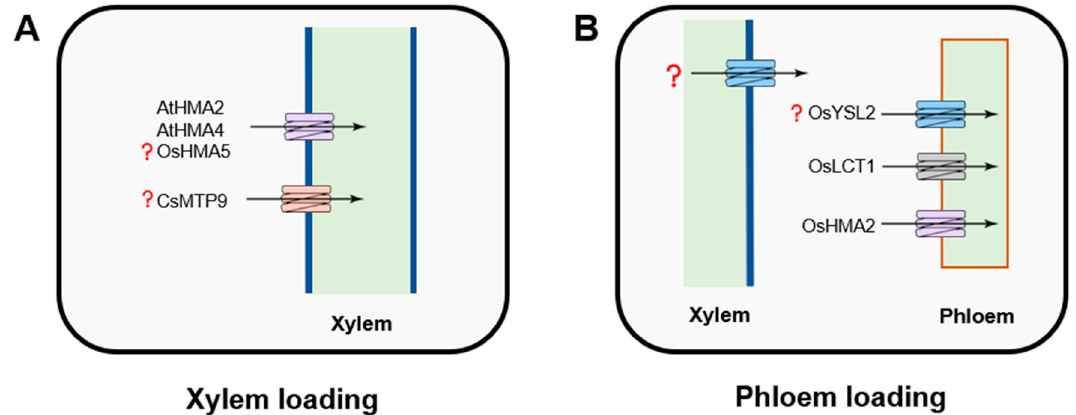
Figure 3. Transporters mediating xylem ( A ) and phloem ( B ) cadmium loading. HMA2 and LCT1 (low-affinity calcium transporter) are functioning in the translocation of Cd into the phloem. The major transporter that regulates xylem Cd loading is HMA2/4. The role of MTP9 in the long-distance Cd transport remains unclear.